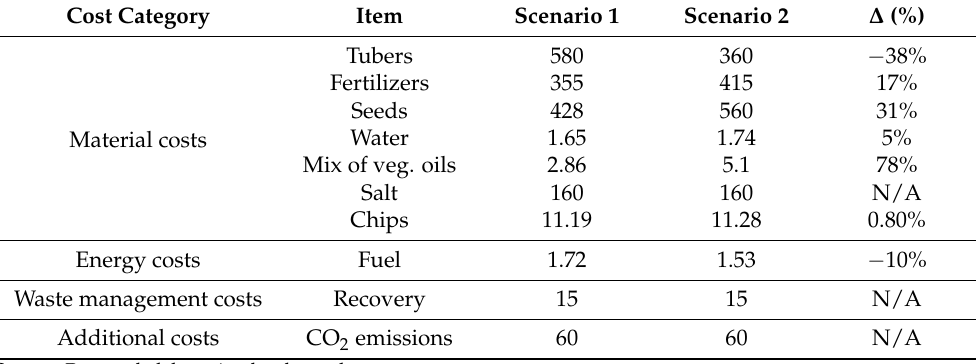
Table 2. Cost categories and data inventory (EUR/t). Cost Category